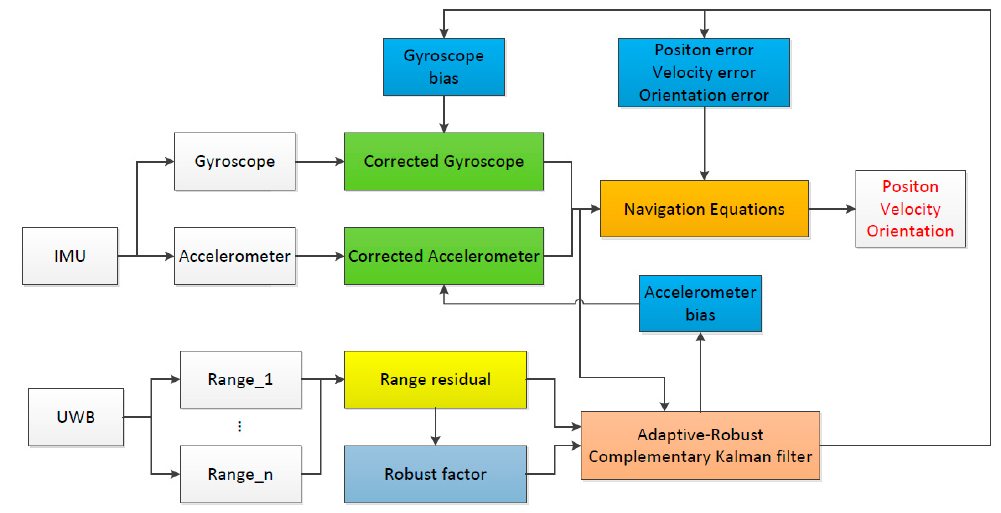
Figure 1. Flowchart of the proposed Adaptive-Robust CKF.